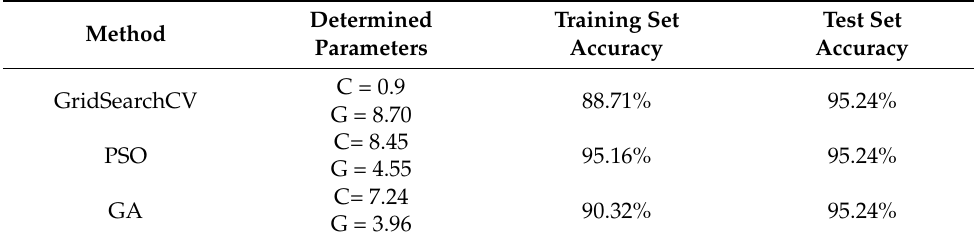
Table 8. Parameters determined by three methods and accuracy of classification model using parameters. these parameters.